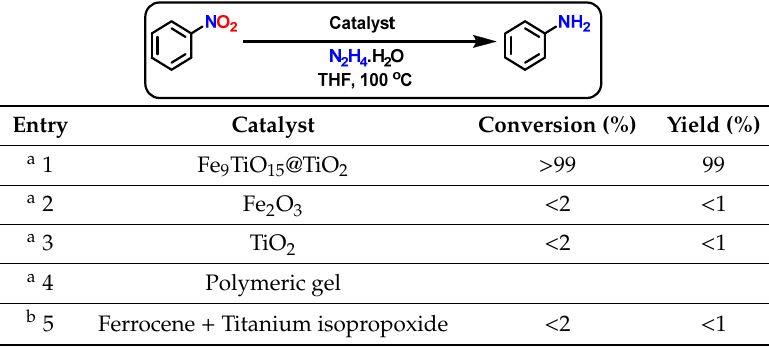
Figure 5. Electron paramagnetic resonance (EPR) spectra of Fe 9 TiO 15 @TiO 2.